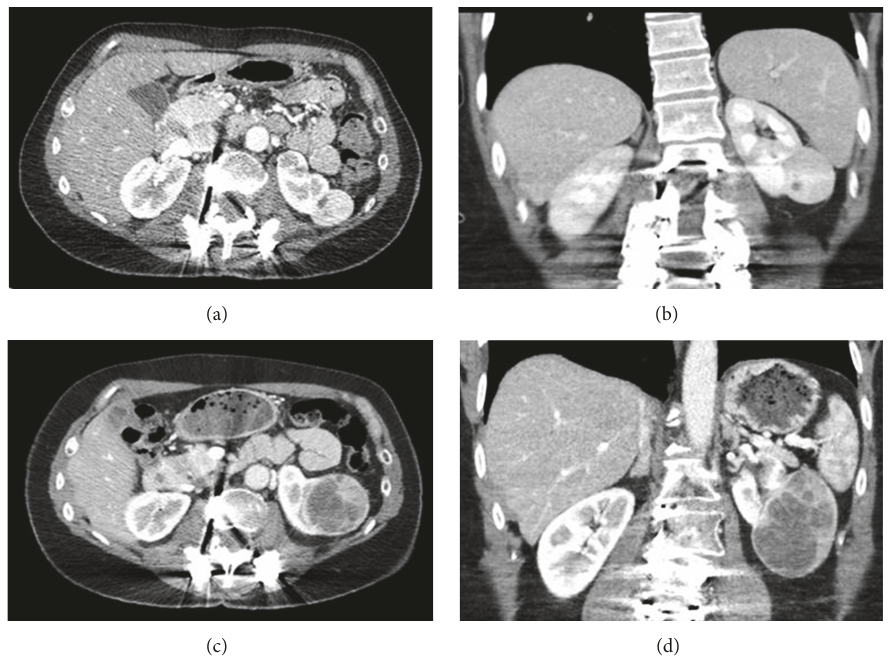
Figure 1: (a)–(d) CT axial and coronal scans depicting an exophytic mass in the lower pole of the left kidney: (a, b) initial presentation showing a well-circumscribed, enhancing mass with two small discrete, low attenuation areas in the inferior portion. (c, d) Enlargement of the renal tumor to almost twice the size from prior examination with compression of calyces, increased heterogeneity, and enhancement at the peripheral and anterior aspects of the